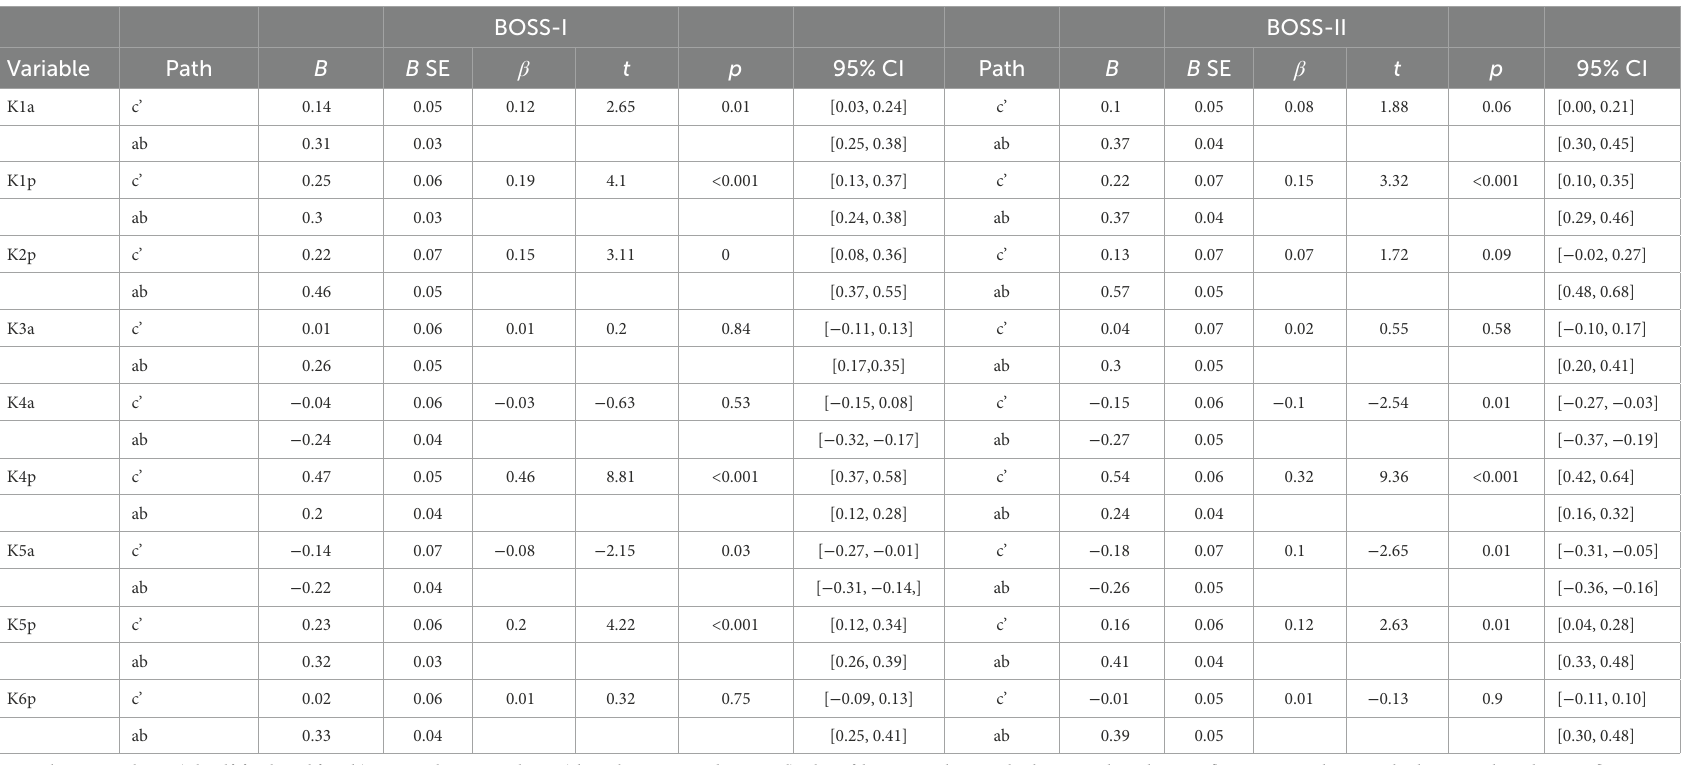
TABLE 7 Total, direct and indirect